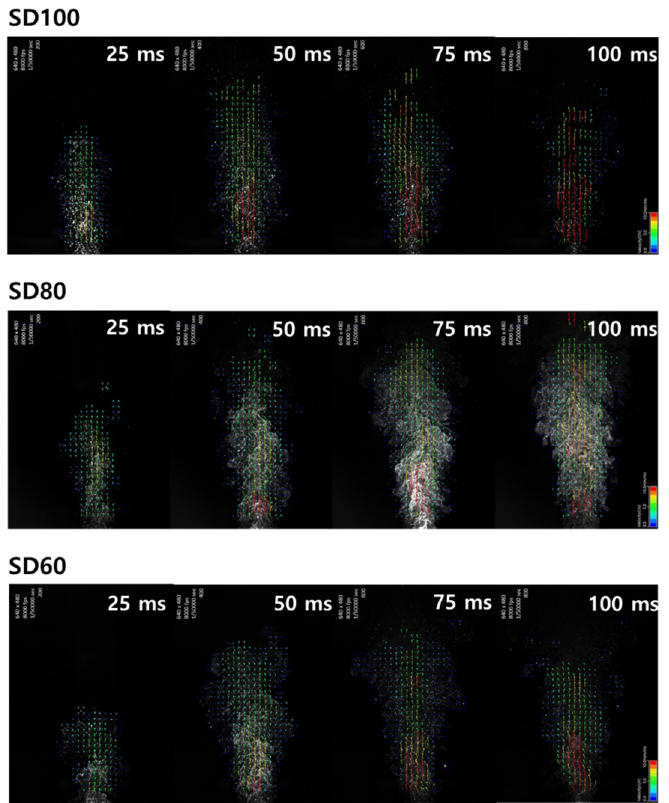
Figure 6. Vector images of particle flow field emitted from DPIs.